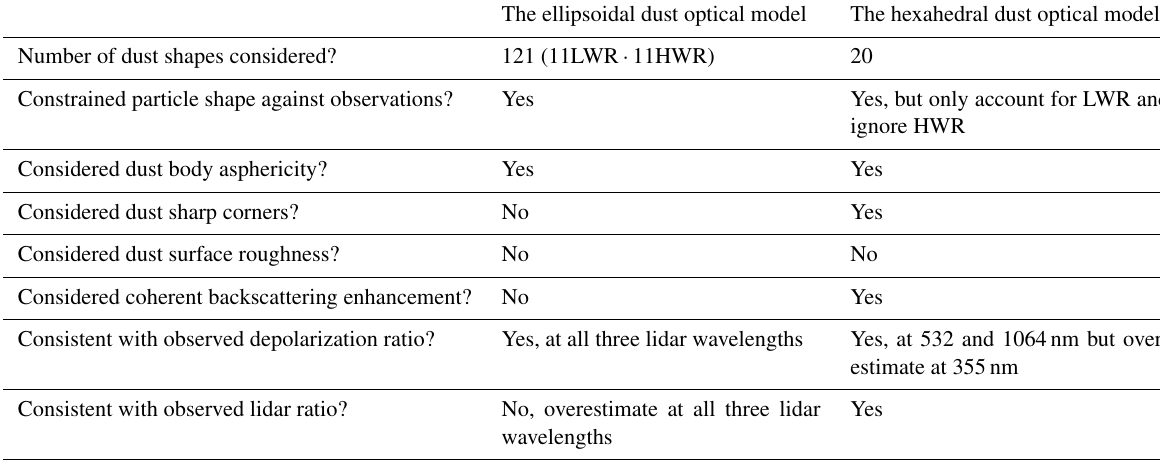
Table 1. A comparison between the ellipsoidal dust optical model (the present work) and the hexahedral dust optical model (Saito and Yang,